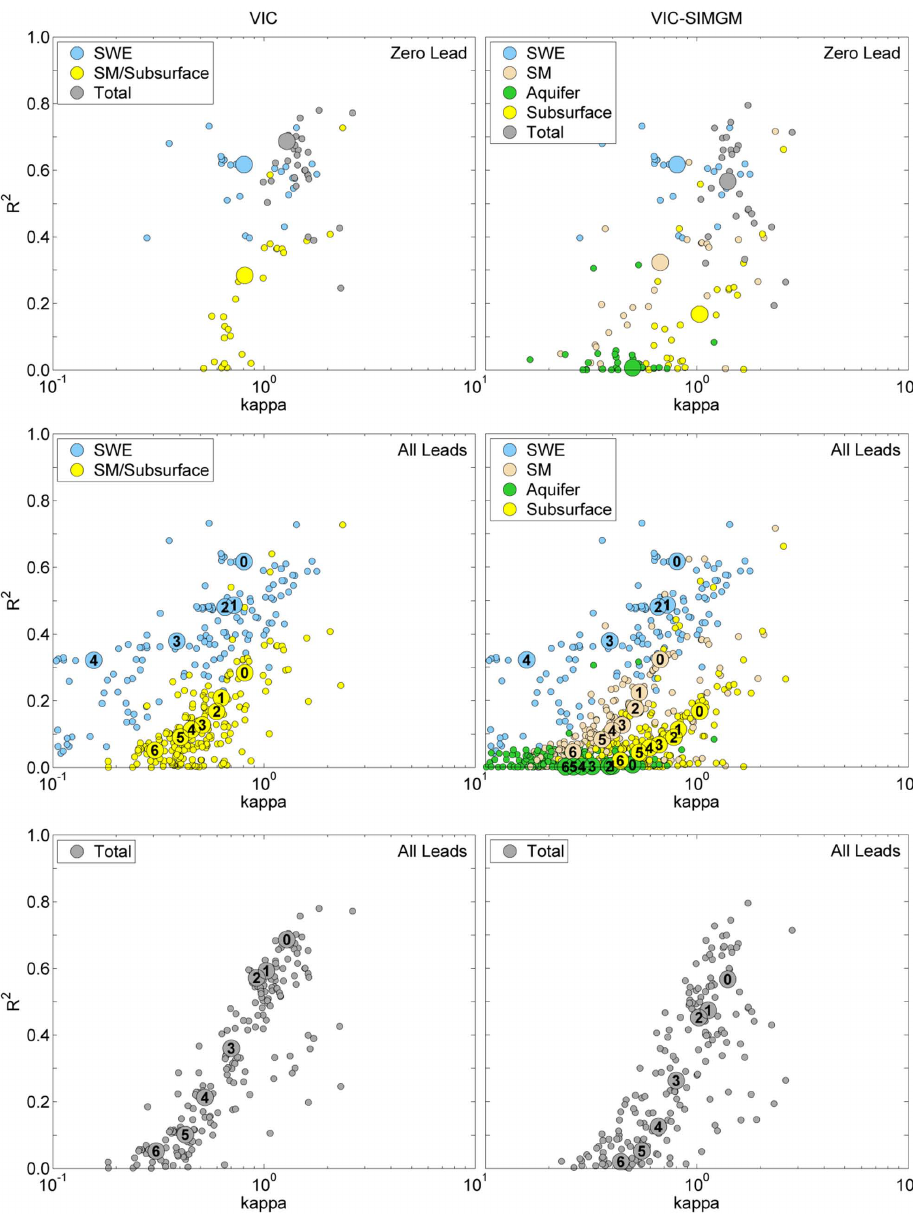
Fig. 12. Scatter plots of forecast skill vs. kappa for various storage term combinations, reflecting an April–July target period. The larger dots in each plot are for Lee’s Ferry, with the numbers inside indicating the lead time in